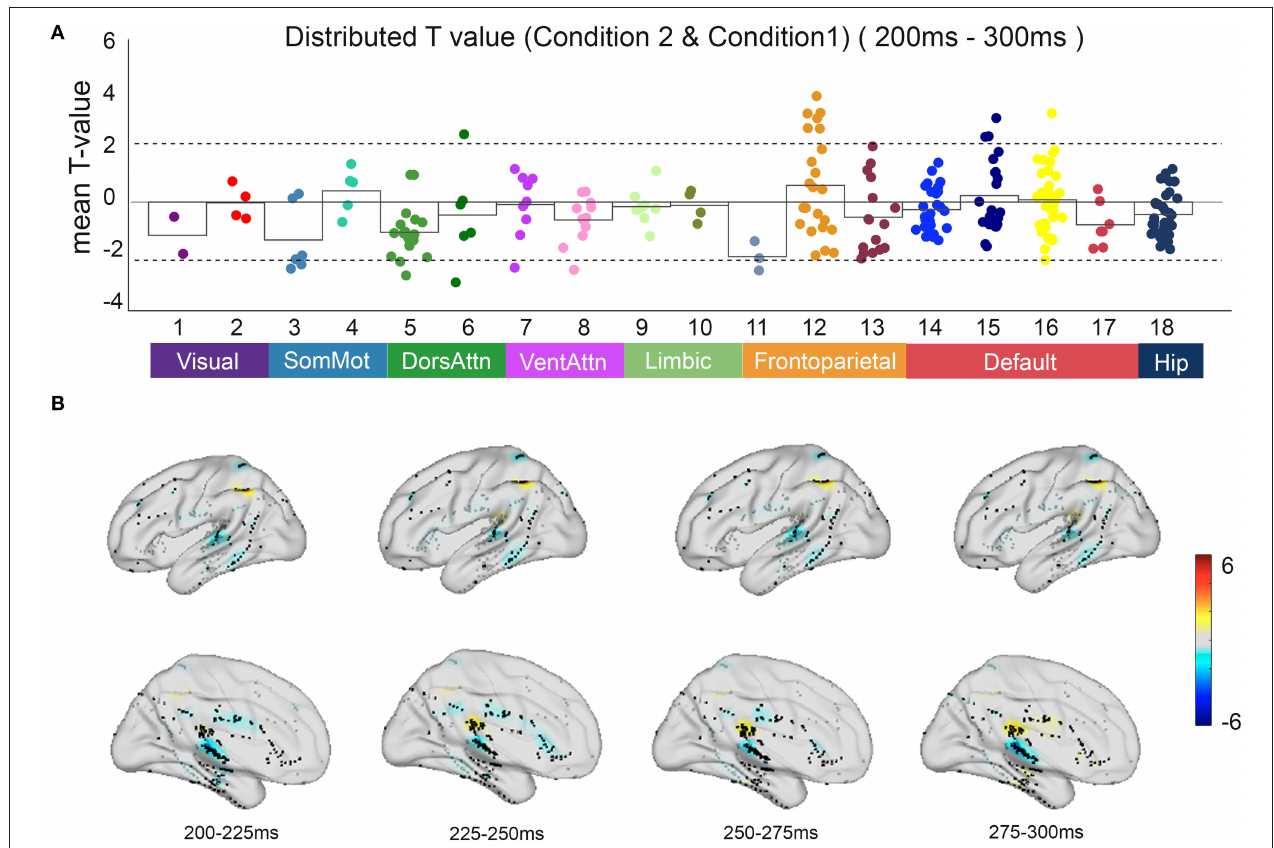
FIGURE 5 | The neural response in functional networks and the spatiotemporal map of irrelevant incongruent condition. (A) Mean t -value distributed across 17 networks and hippocampus during 200–300ms between the irrelevant incongruent condition and congruent condition. Significant responses were detected on the frontoparietal control network and default mode network ( t -value > 2, p < 0.05). (B) The t -value map shows dynamics between the irrelevant incongruent condition and congruent condition. Color intensity indicates t -value of positive (red) or negative